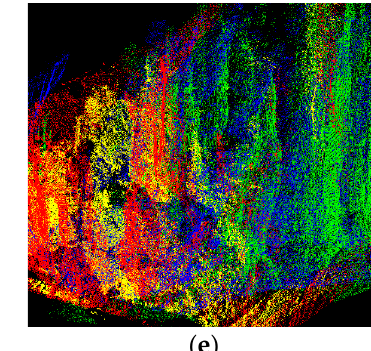
Figure 8. Local details of point cloud registration of the cliff wall in Huidong County, Sichuan Prov- ince. ( a ) PC-MVCNN; ( b ) Improved CPD; ( c ) PointNetLK; ( d ) 3D-NDT; ( e ) SAC + ICP. Table 4. Registration results of various algorithms for cliff point cloud data in Huidong County, Sichuan Province.